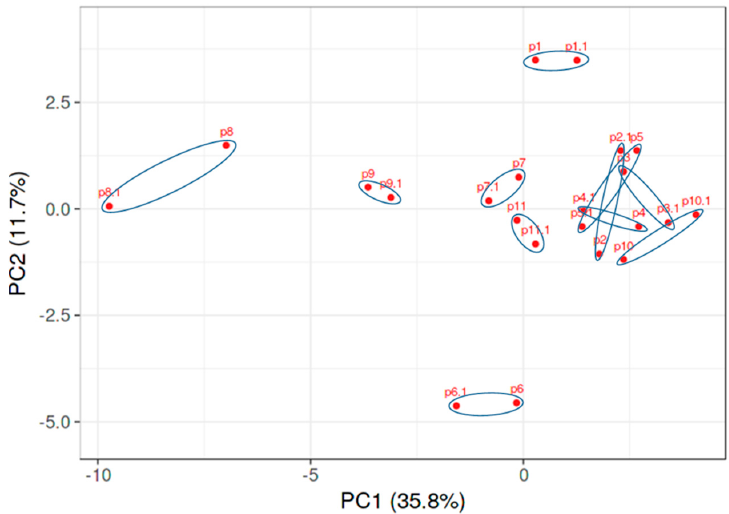
Figure 2. High reproducibility of PAH metabolic profile obtained from two independent experiments. An analysis of two independent runs of plasma metabolites from PAH patients ( n = 11). Circles indicate the same patient in two experiments.